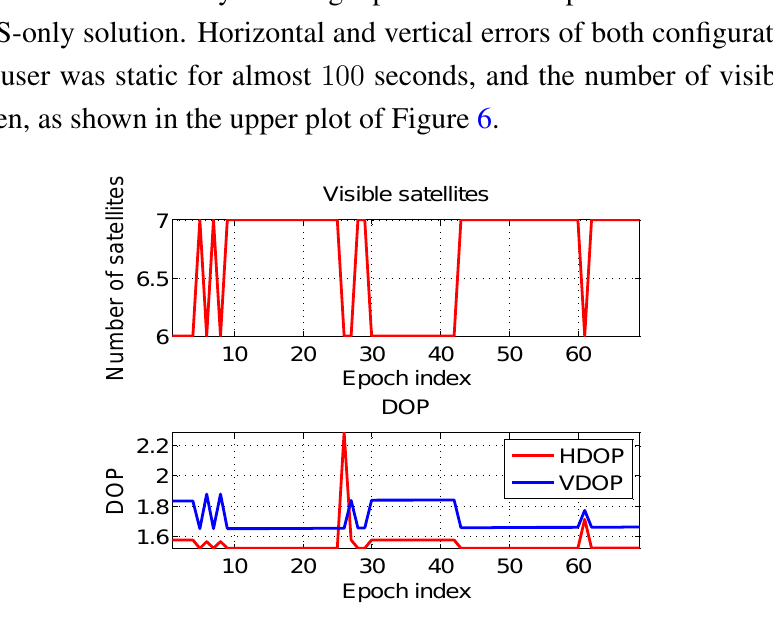
Figure 6. Number of visible satellites and dilutions of precision (DOPs) recorded during the test conducted in the partially-obstructed